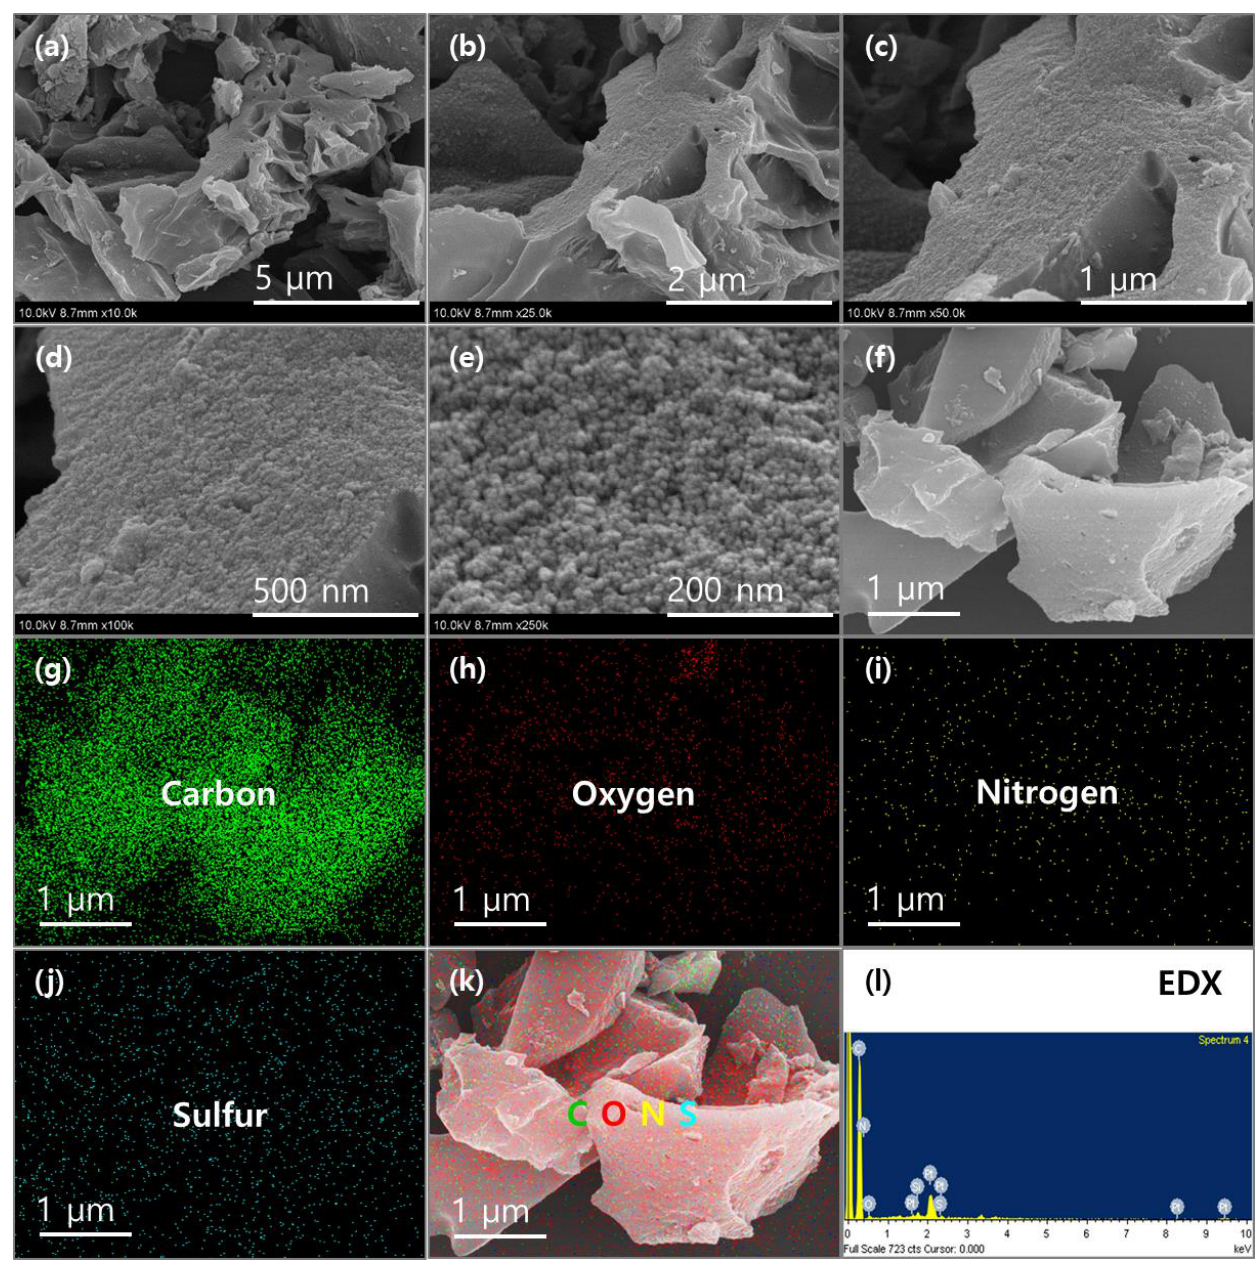
Figure 1. ( a – e ) FE-SEM images at different magnifications of synthesized H-PCM; ( f ) FE-SEM electron image of synthesized H-PCM and the corresponding EDX mapping of ( g ) carbon, ( h ) oxygen, ( i ) nitrogen, ( j ) sulfur, and ( k ) overlapping of all the presented elements; ( l ) EDX spectrum results of presented elements in the synthesized H-PCM.